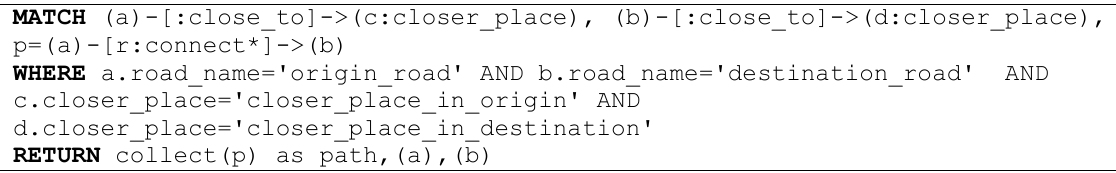
Fig. 7. Cypher query to search multimodal transportation.